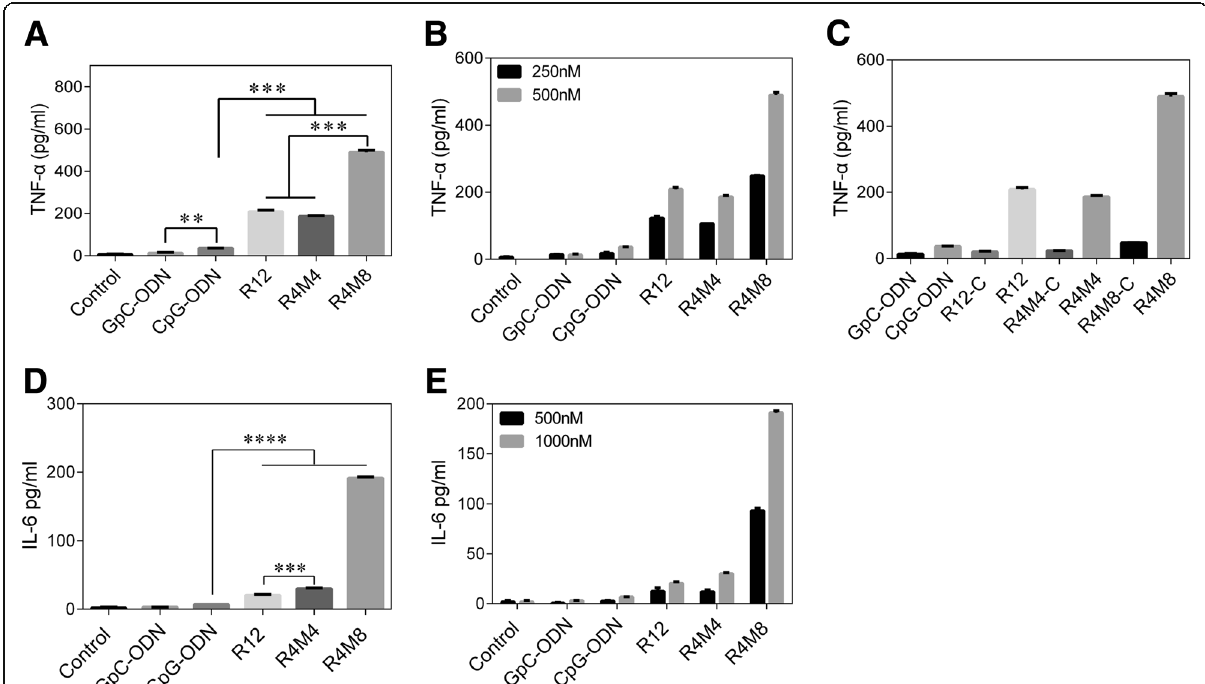
Fig. 3 Detection of cytokines released from RAW264.7 cells stimulated with CpG-ODN, CpG-RCA gel, and CpG-MCA gels using ELISA-kit. a The secretion of TNF- α from RAW264.7 cells. b The secretion of TNF- α from RAW264.7 cells after treated with different concentrations of CpG-MCA gels. c Detection of the immuno-stimulating ability of CpG gels and non-CpG gels (R12-C, R4M4-C, and R4M8-C). d The secretion of IL-6 from RAW264.7 cells. e The secretion of IL-6 from RAW264.7 cells after treated with different concentrations of MCA gels. Results are expressed as the mean ± SD of two independent experiments. ** P < 0.01, *** P < 0.001, **** P <